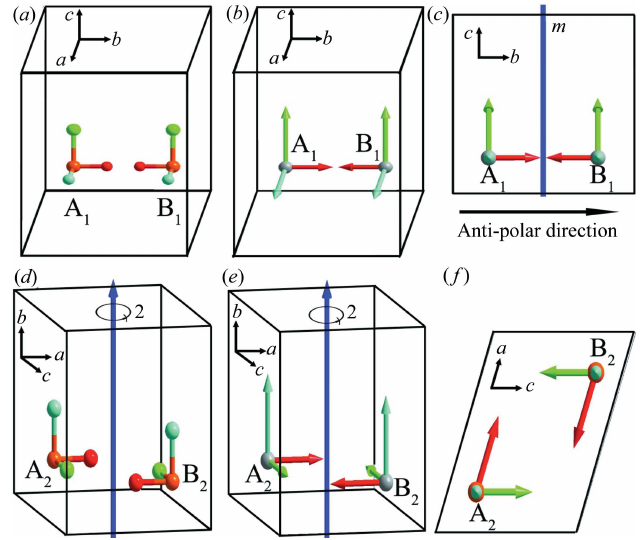
Figure 3 ( a ) Schematic for point group m ( C 1 h ). ( b ) and ( c ) Transformation of the dipole moment in point group m ( C 1 h ) viewed along different crystal- lographic directions. ( d ) Schematic for point group 2 ( C 2 ). ( e ) and ( f ) Transformation of the dipole moment in point group 2 ( C 2 ) viewed along different crystallographic directions. In ( a )–( f ), a 6¼ b 6¼ c , (cid:2) = (cid:4) = 90 (cid:4) , (cid:3) 6¼ 90 (cid:4)